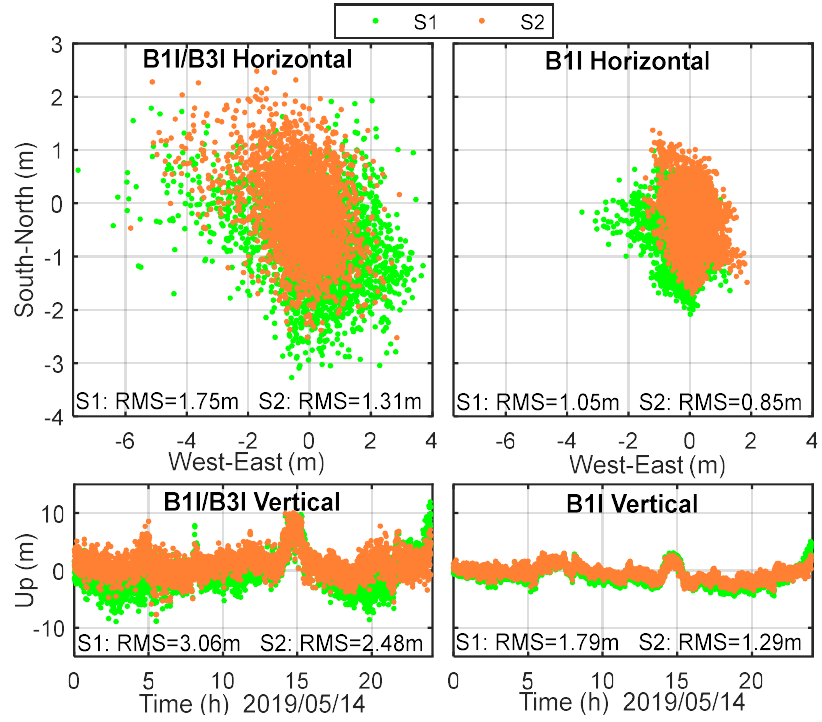
Figure 10. Horizontal and vertical positioning error of B1I/B3I ( left ) and B1I ( right ) SPP at station MCHL (Mitchell, 26.36°S, 148.15°E).